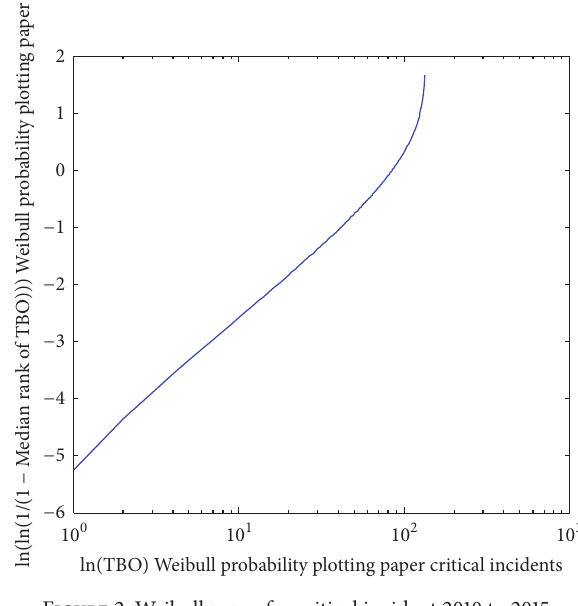
Figure 2: Weibull paper for critical incident 2010 to